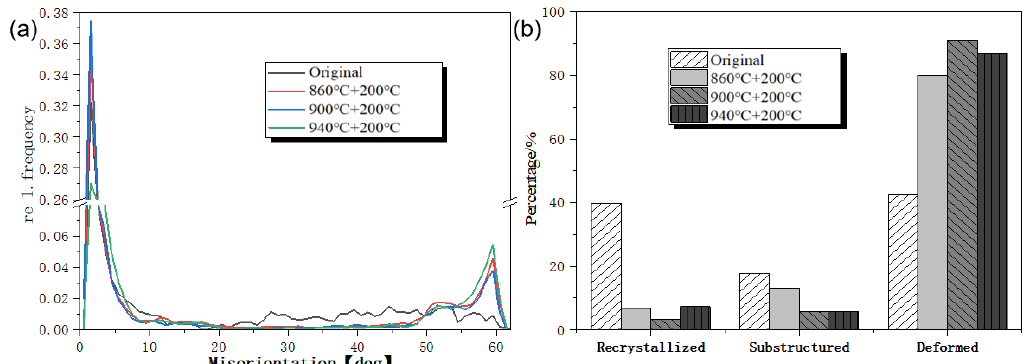
Figure 4. Grain boundary dislocation distribution and recrystallization: ( a ) misorientation scale diagram under different conditions; ( b ) grain scale diagram in different states.